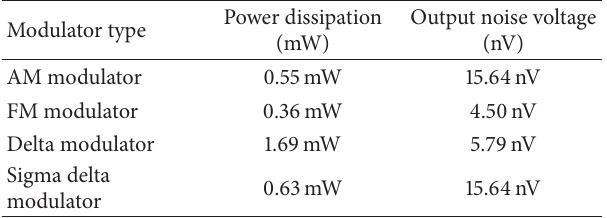
Table 3: Performance characteristics of DVCCTA based modula-